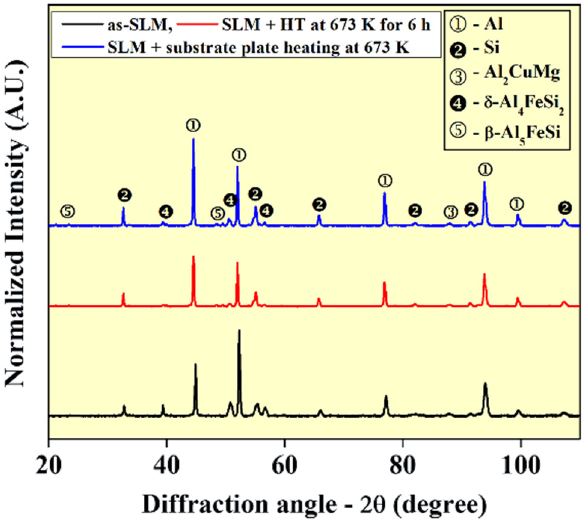
Figure 4. X-ray diffraction patterns of the SLM processed Al-20Si-5Fe-3Cu-1Mg samples. During solidification, the primary Si precipitates first, and then the metastable δ -Al 4 FeSi 2 should form [60]. Once the nucleation of δ -Al 4 FeSi 2 phase takes place, both Fe and Si elements diffuse to the edge of δ -Al 4 FeSi 2 phase because of the decreasing solubility of these two elements in α -Al matrix [61], promoting further growth of δ -Al 4 FeSi 2 phase with which can be accomplished via the diffusion of Fe and Si atoms from δ -Al 4 FeSi 2 phase to α -Al matrix. However, low diffusion coefficients of Fe and Si atoms in α -Al matrix (D Fe = 7.923 × 10 − 14 m 2 /s and DSi = 1.524 × 10 − 12 m 2 /s at 883 K, calculated according to [63]). In